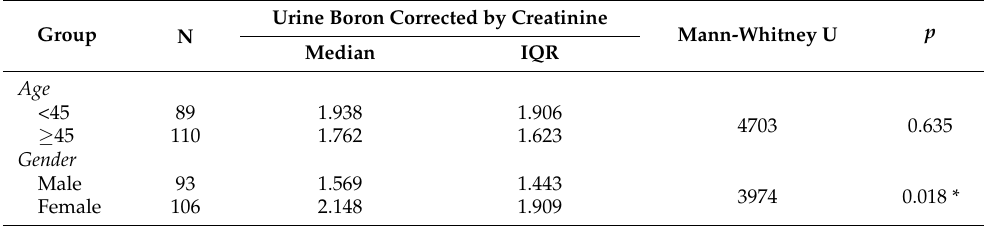
Table 4. Urine boron concentrations in different ages and genders (mg/g creatinine).